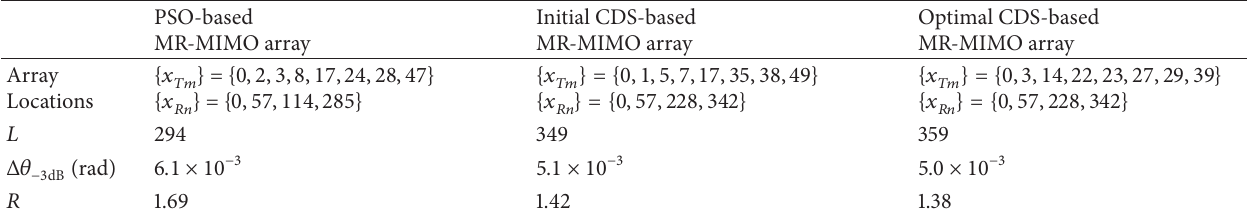
Table 1: Comparisons of different MR-MIMO layouts with their characteristics ( 𝑀 = 8 , 𝑁 = 4 ).